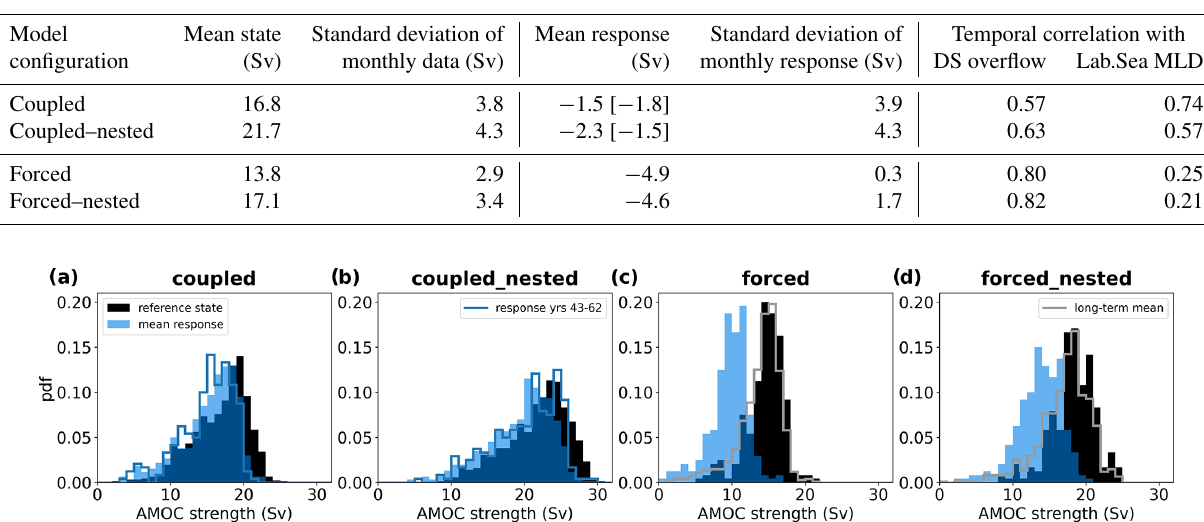
Table 2. AMOC mean state and response to freshwater perturbation measured by the maximum transport in the overturning streamfunction computed from zonally averaged Atlantic basin meridional velocities. Mean state and response are computed over years 1–100 (1–62) and 51–100 (43–62) for coupled (forced) experiments, respectively. Additionally, responses for the two coupled experiments computed as average over years 43–62 are provided in square brackets. The standard deviation σ based on monthly mean model output is provided as a measure of internal variability and noise in the signal of the response. Correlation coefficients (Pearson’s r ) between annual-mean AMOC strength and Denmark Strait (DS) overflow potential density ( p ref = 0) as well as March-mean mixed-layer depths (MLDs) in the Labrador Sea after applying a decadal boxcar averaging filter to all time series are listed. Correlations are computed from the reference experiment over 100 and 62 years for the coupled and forced configurations, respectively, applying an 11-year rolling mean to highlight a linkage on decadal and longer timescales. All values are given in sverdrup (1Sv = 10 6 m 3 s − 1 ), except for the correlation coefficients in the last two columns.